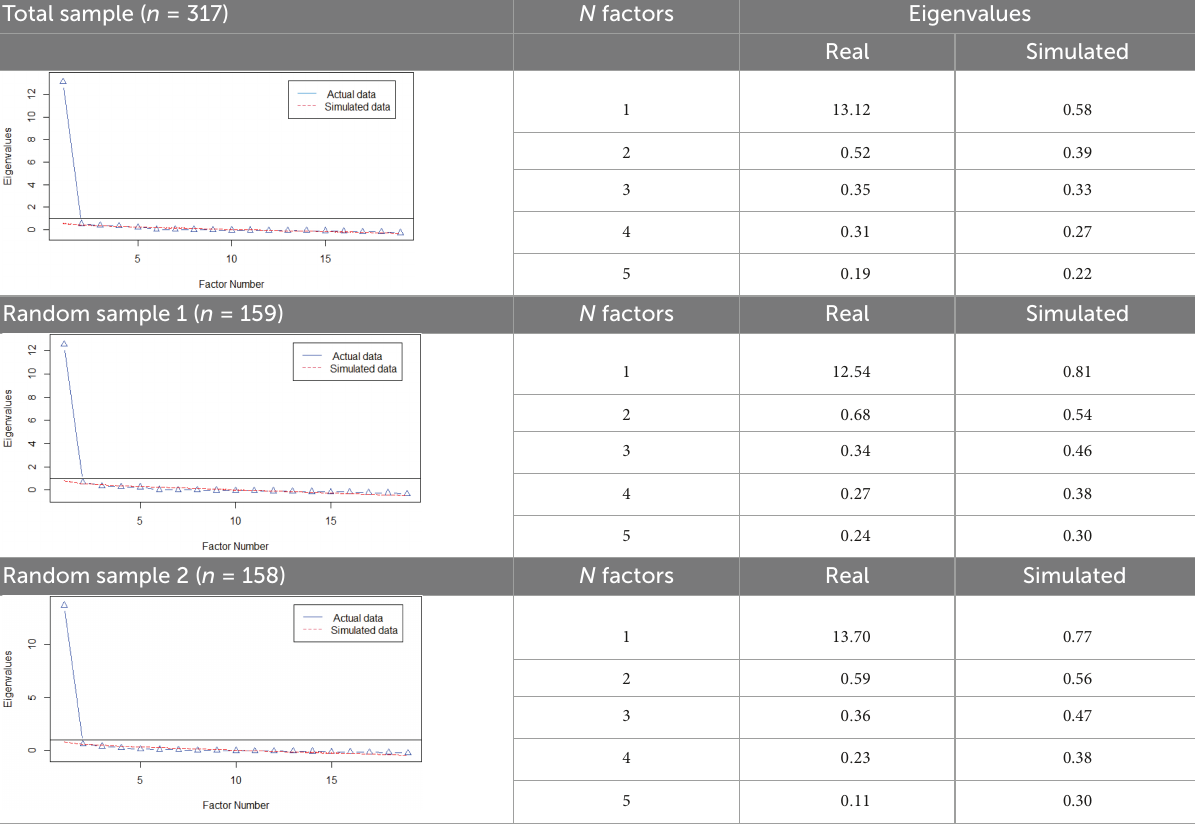
TABLE 5 Parallel analysis (number of factors). Total sample ( n =